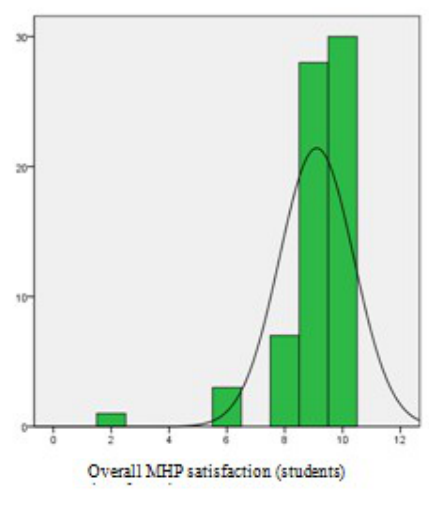
Figure 2. Score distributon of overall student satsfacton with the MHP